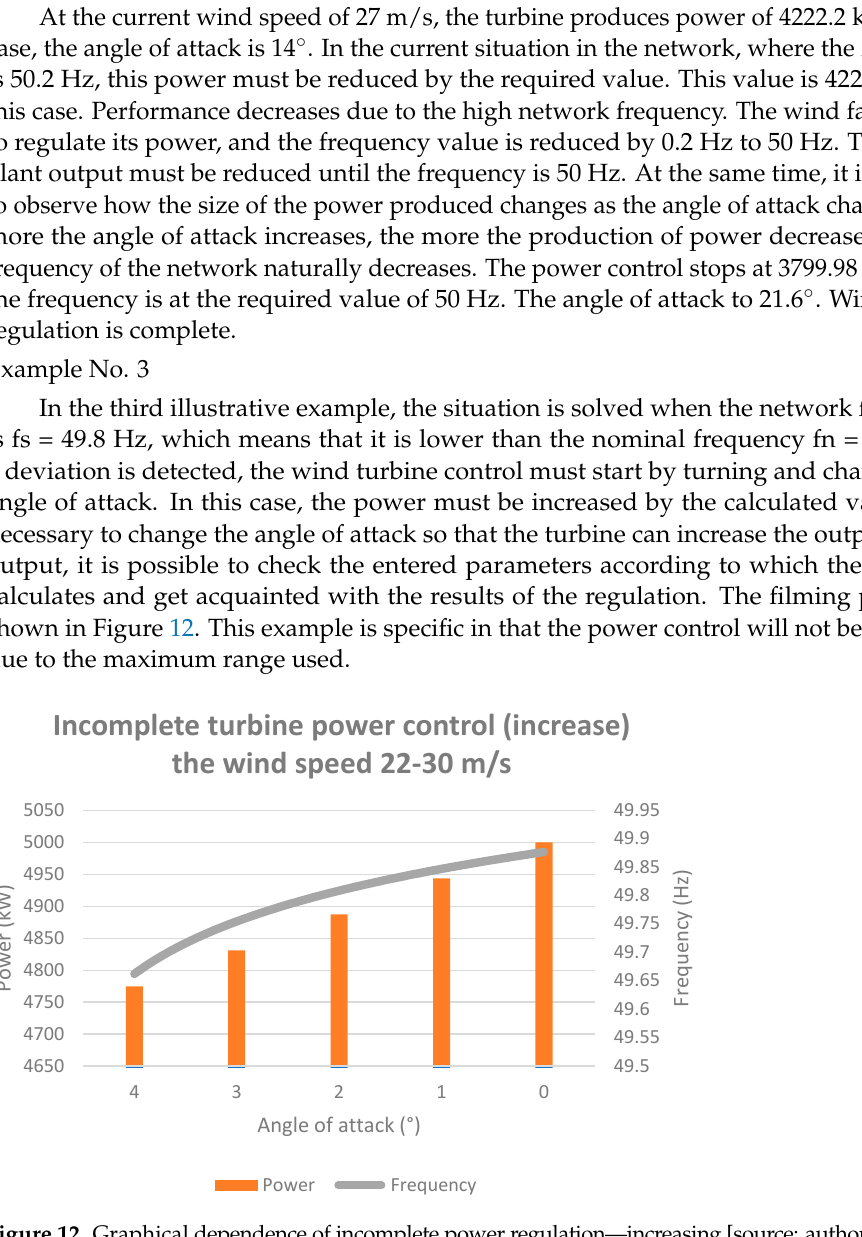
Figure 12. Graphical dependence of incomplete power regulation—increasing [source: author’s ar- chive] .